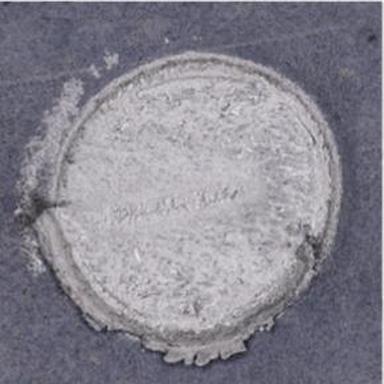
Post-failure macro-images of Usibor® 1500-AS and Ductibor® 1000-AS spot welds under shear and normal loading.